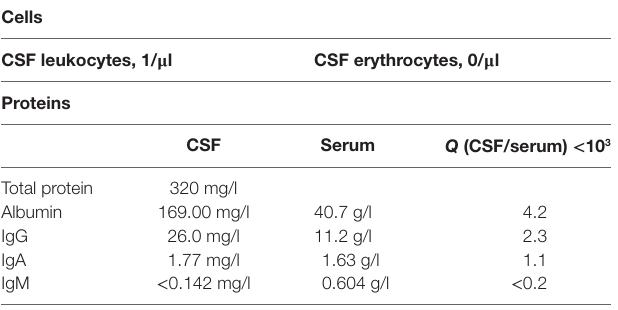
taBLe 3 | CSF parameters in our patients sample (13 June